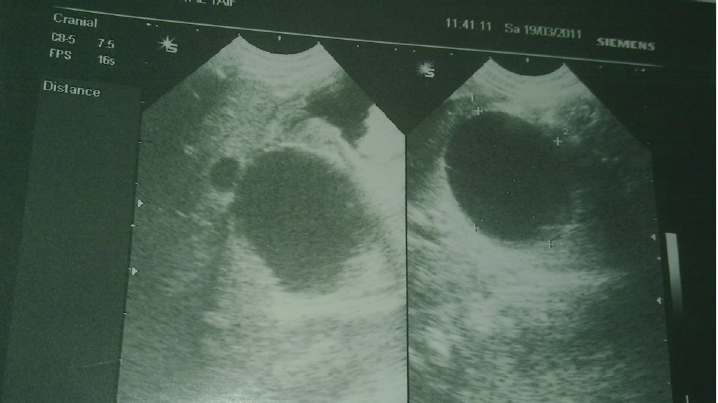
Figure 2 : Ultrasound of the abdomen showing a cystic mass measuring 37 × 33 mm at the epigastric region adjacent to the head of the pancreas.